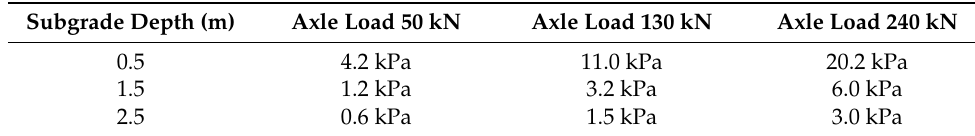
Figure 3. Schematic diagram of wheel action. Table 3. Vibration